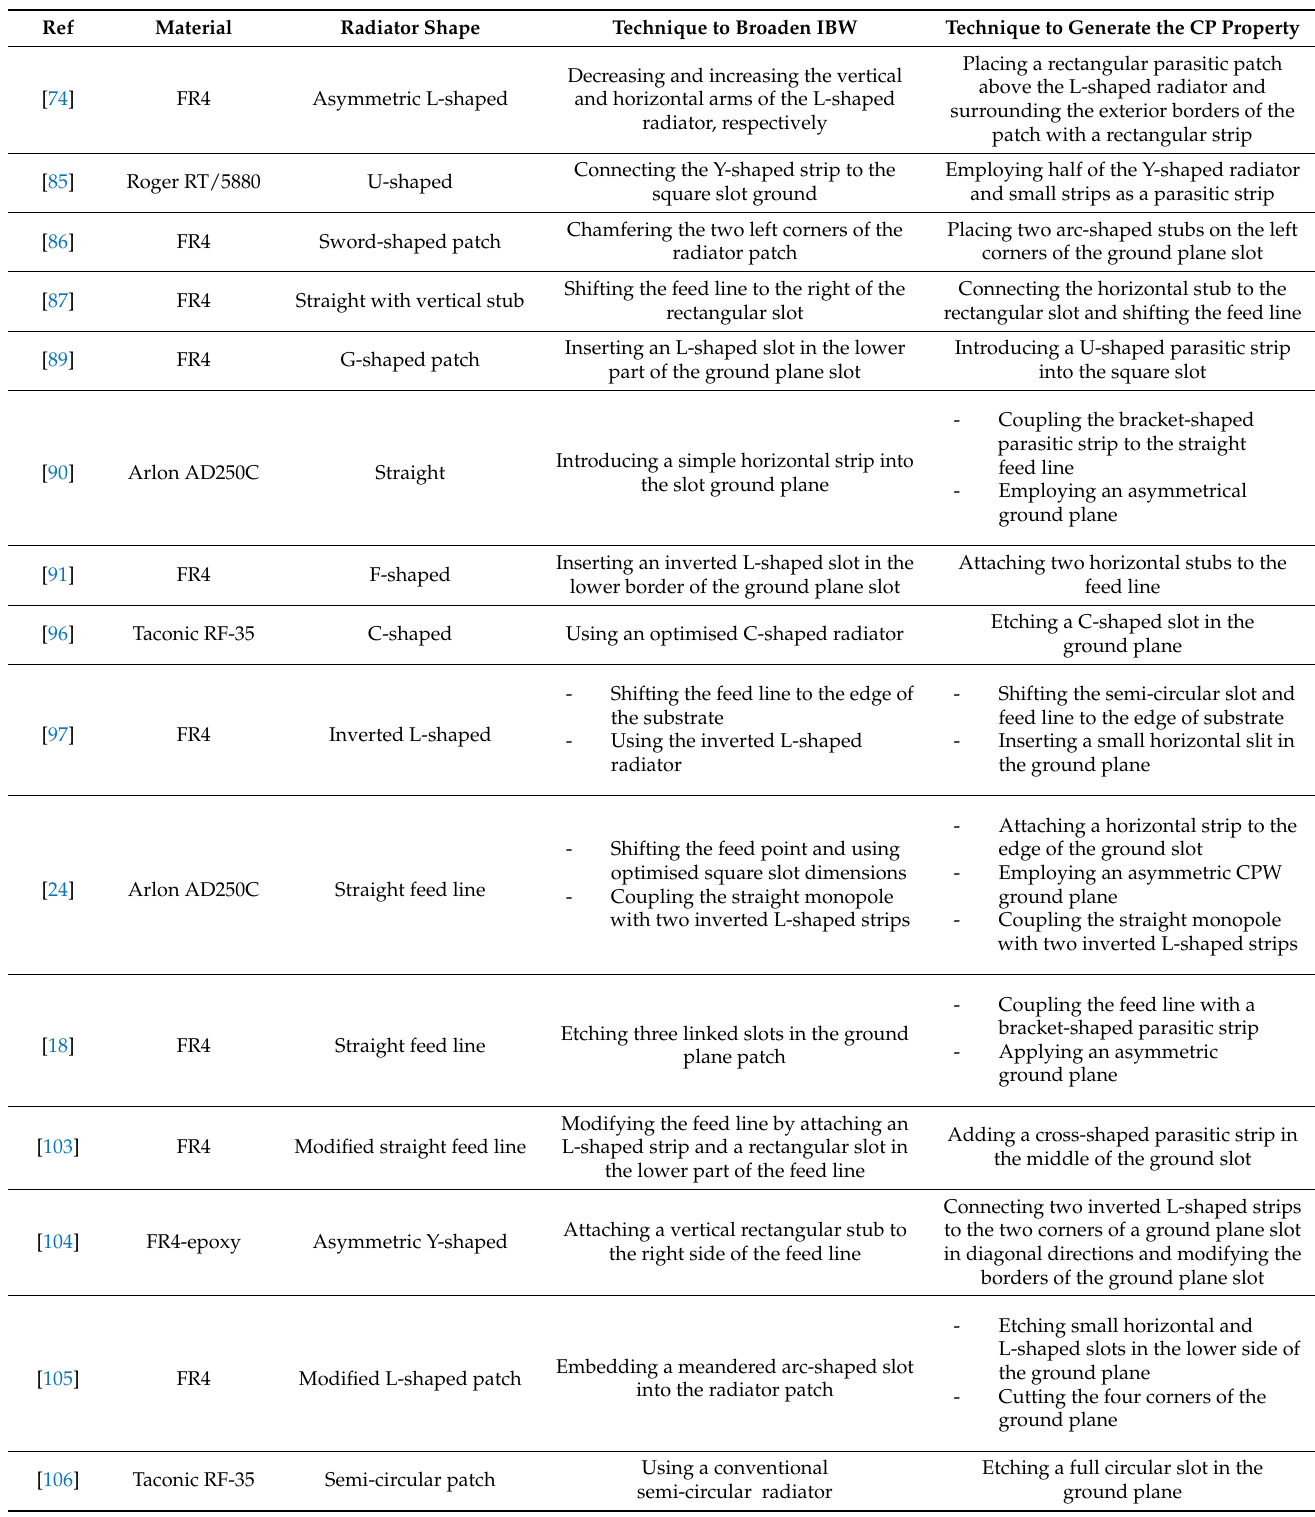
Table 3. Summary of BCPPSAs from the